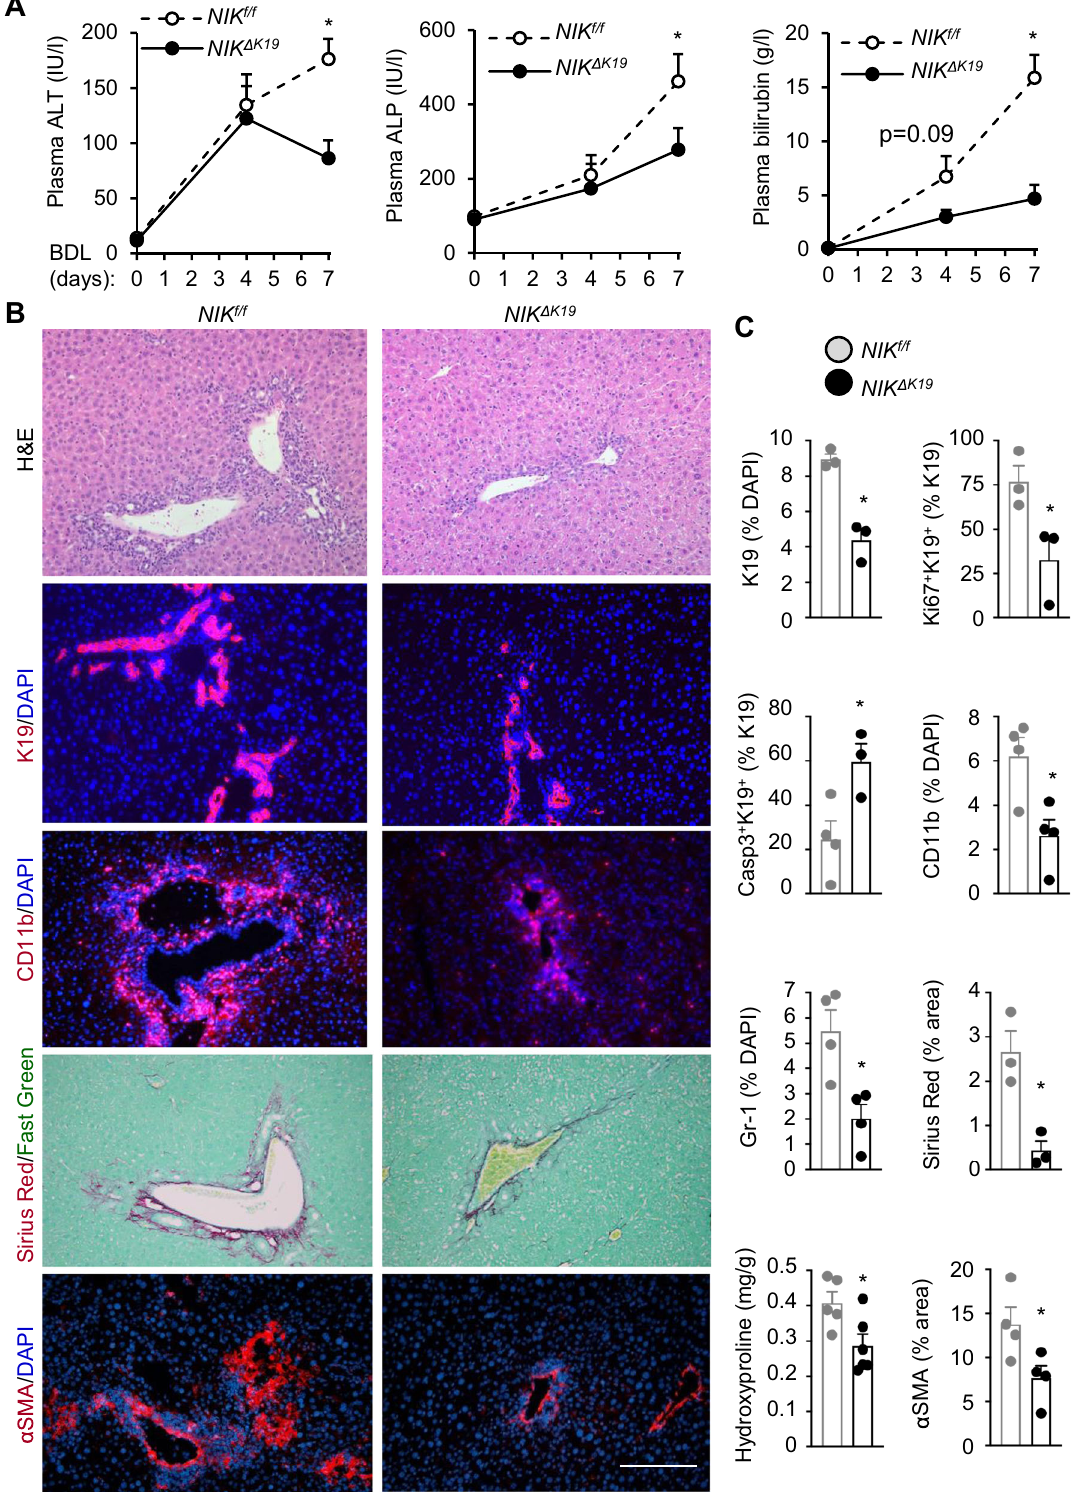
Fig. 6 | Ablation ofbiliary NIK attenuatesBDL-induced ductular reaction, liver injury,andin fl ammation. BDLwasperformedon NIK Δ K19 and NIK f/f malemice,and liverswereanalyzed7dayslater. A PlasmaALT,ALP,andtotalbilirubinlevels( n =6 mice per group). B , C Liver sections were stained with the indicated antibodies. B Representative images. Scale bar: 200 μ m. C Individual subpopulations were counted and normalized to total liver cells. Sirius red area was normalized to total